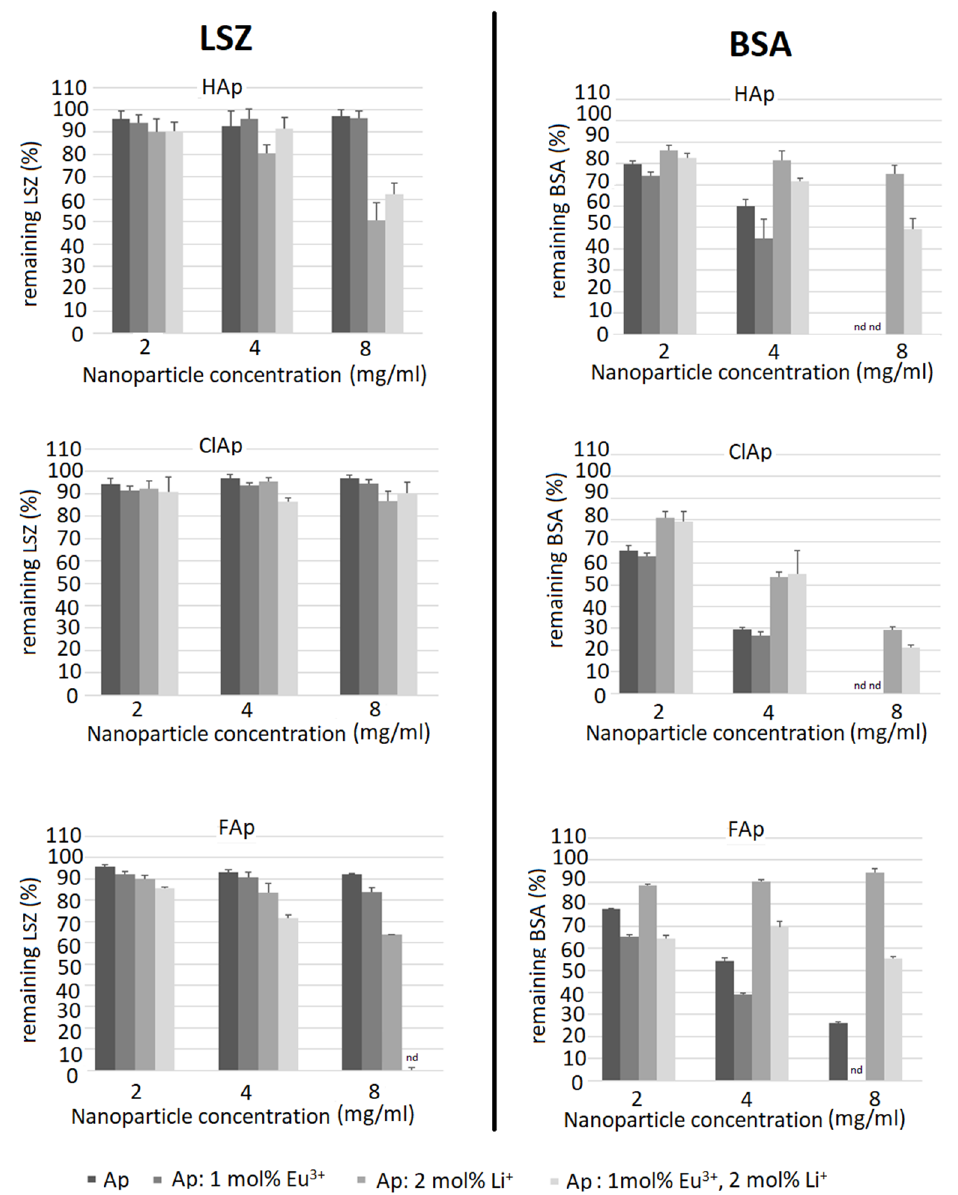
Figure 14. Relative lysozyme (LSZ) ( left panel ) and bovine serum albumin (BSA) ( right panel ) adsorption to un-doped nanoapatites (Ap—HAp, ClAp, FAp) as well as nanoapatites doped and co-doped with Eu 3+ /Li + ions. Nanoparticle dispersions in 0.05% LSZ and BSA were incubated for 4 h, centrifuged and the supernatants were assessed for protein concentration. Solutions of 0.05% LSZ and BSA were used as control (100% protein concentration).